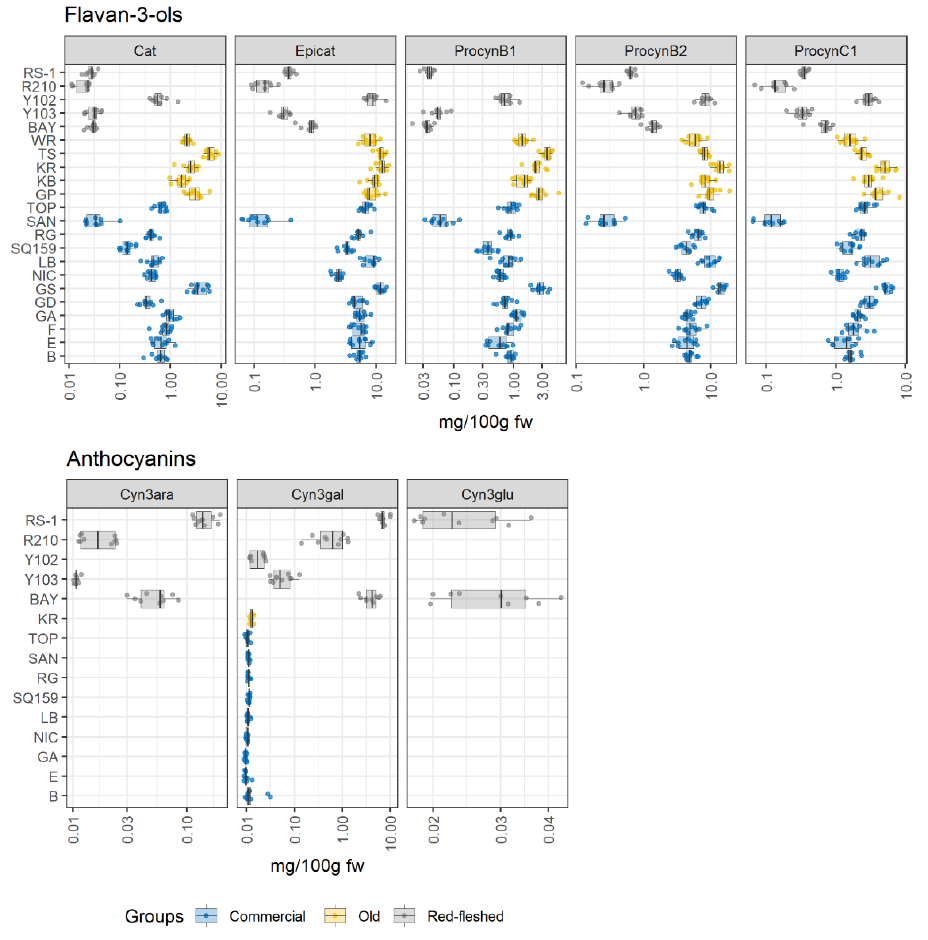
Figure 2. Concentration of flavan-3-ols and anthocyanins in the pulp of 22 apple varieties; 10 apples (biological replicates) per variety were analyzed. The concentrations of these metabolites were transformed in a log-10 scale. Varieties where anthocyanins were not detected have not been included in the graph. Cat = catechin, Epicat = epicatechin, ProcyanB1 = procyanidin B1, ProcyanB2 = procyanidin B2, ProcyanC1 = procyanidin C1, Cyn3ara = cyanidin-3-arabinoside, Cyn3gal = cyanidin-3-galactoside, Cyn3glu = cyanidin-3-glucoside, FW = fresh weight. For apple variety names see Table 1.